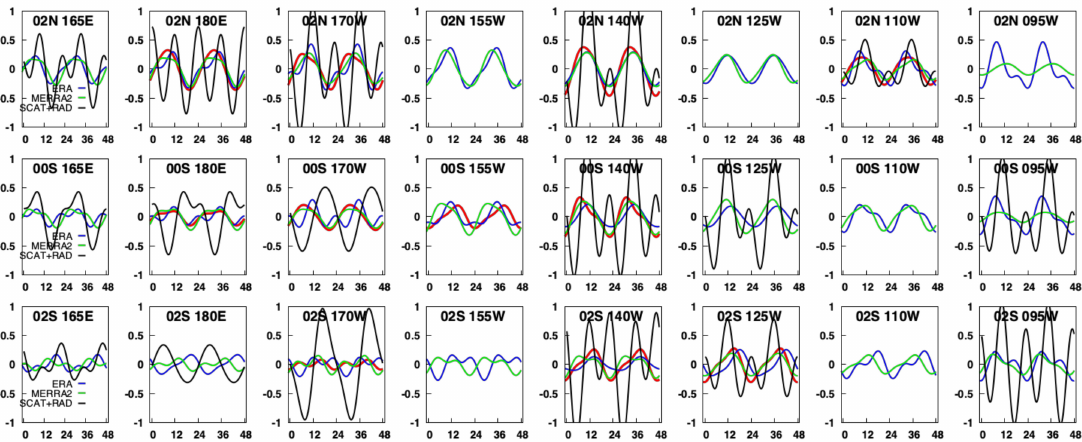
Figure 12. Same as Figure 9, but showing meridional ( v ) wind components from 2010, a year with moderate La Niña conditions. Positive (negative) values indicate southerly (northerly) winds relative to the daily mean. For many locations, the TAO-TRITON and SCAT + RAD data are not shown owing to the limited number of observations.